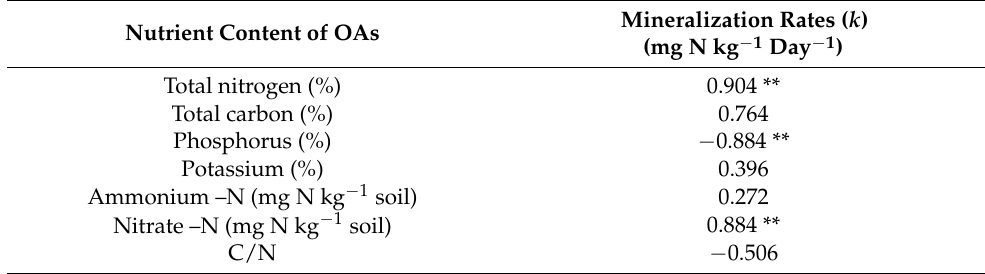
Table 6. Pearson correlation coefficient between N mineralization rates (k, (mg N kg − 1 day − 1 ) and the nutrient content of composted organic